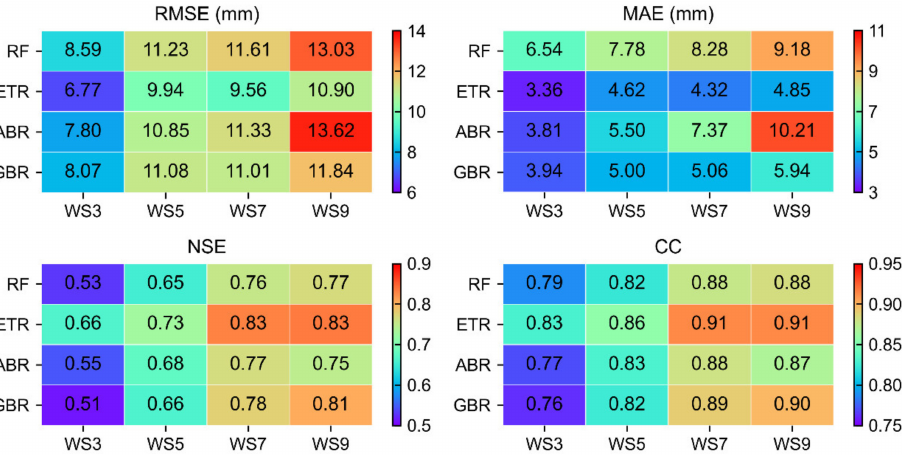
Figure 4. Accuracy statistics of different combined downscaling